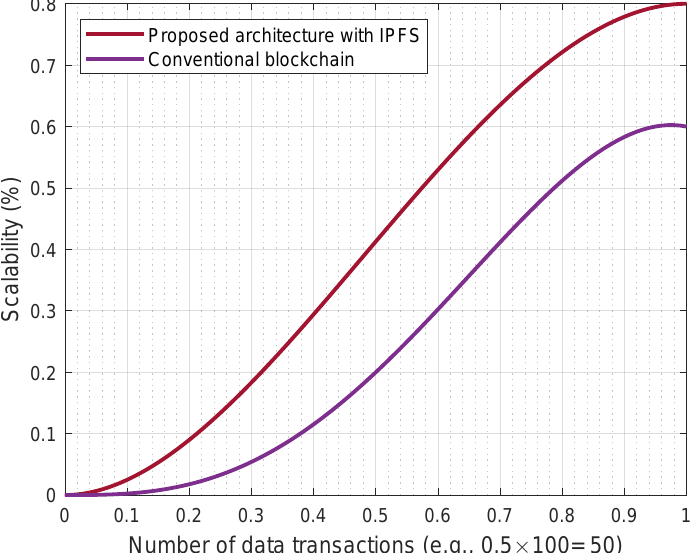
Figure 5. Comparison of blockchain scalability.